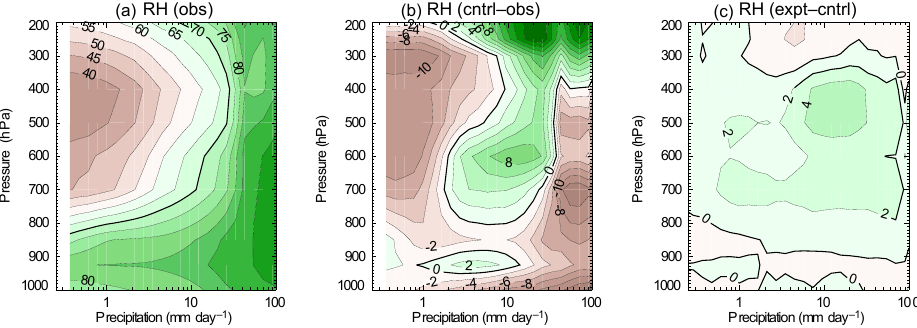
1 . 35, r 1]. Panel (b) shows the [ α 1 . 35, r 1] profile for model levels under 700hPa used = = = = 1 . 35, r 1] is maintained for model levels between 700 and 400hPa (c) , whilst the rest = = 1 . 35, r 2] profile. = =